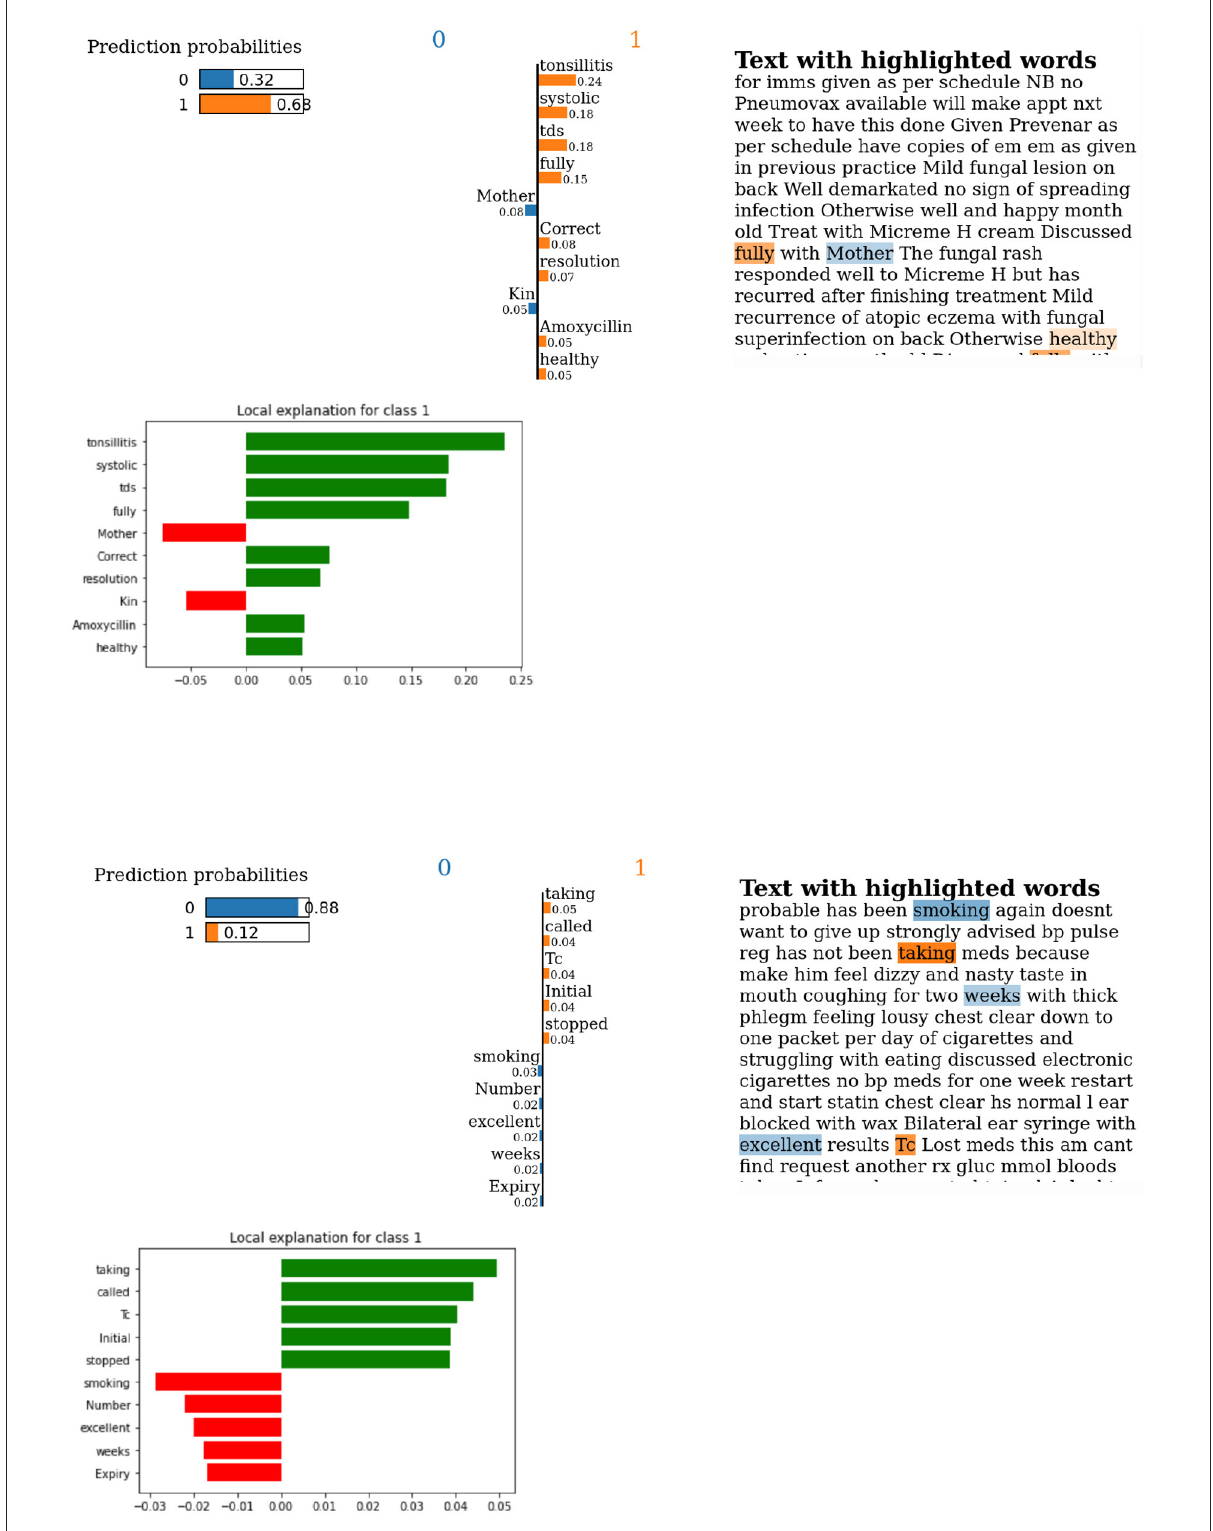
FIGURE8 Lime output for examples of predictions using BOW with LR using NZ-GP Harms data. (Top) True label and prediction label are both indicating “Harm.” (Bottom) True label is “Harm,” but predicted is “no Harm.” Label 1 is “Harm,” and label 0 is “no